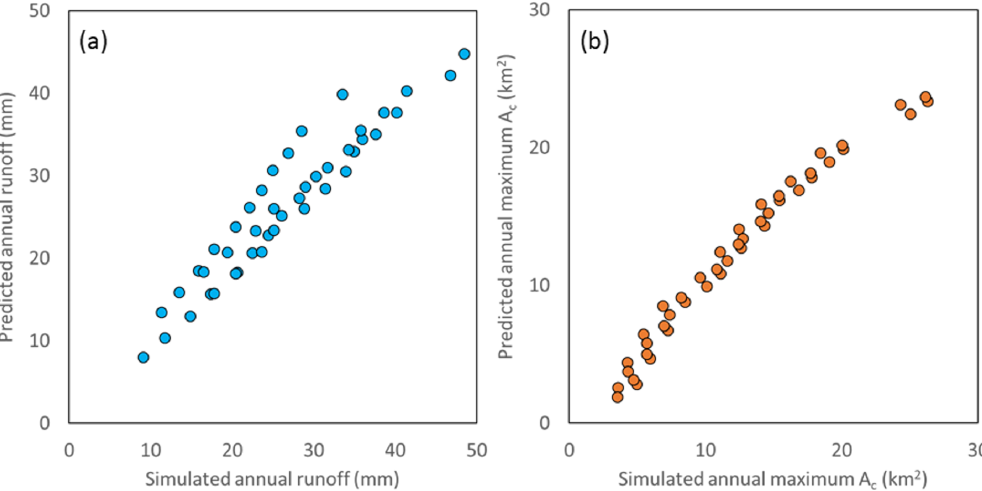
Figure 10. (a) CRHM-simulated mean annual runoff vs. mean annual runoff predicted using Eq. (6) and (b) CRHM-simulated mean annual maximum contributing area vs. mean annual maximum contributing area using Eq.